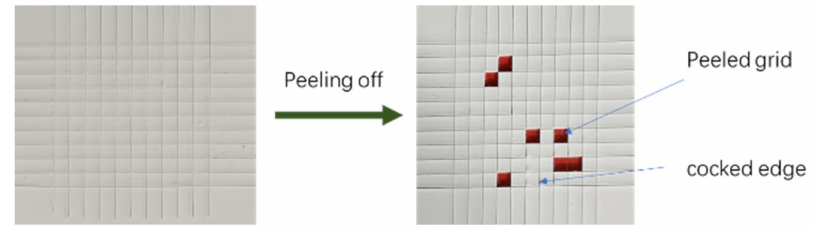
Figure 2. Schematic of the interfacial strength evaluation.